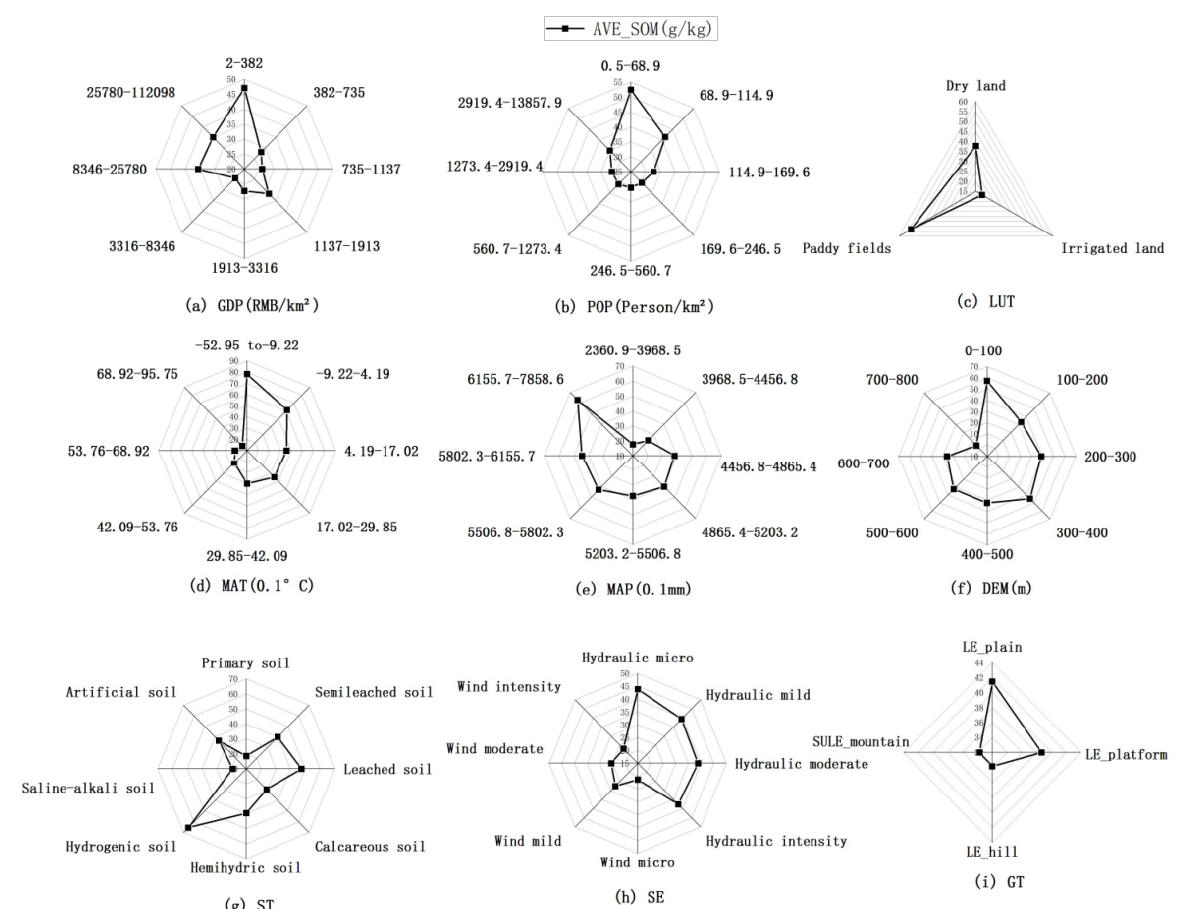
Figure 5. Average SOM values with different grades for all factors. ( a ) Average SOM values with different grades for pixelized gross domestic product map; ( b ) average SOM values with different grades for pixelized population map; ( c ) average SOM values with different grades for land use type; ( d ) average SOM values with different grades for mean annual temperature; ( e ) average SOM values with different grades for mean annual precipitation; ( f ) average SOM values with different grades for digital elevation model; ( g ) average SOM values with different grades for soil type; ( h ) average SOM values with different grades for soil erosion data; ( i ) average SOM values with different grades for geomorphic